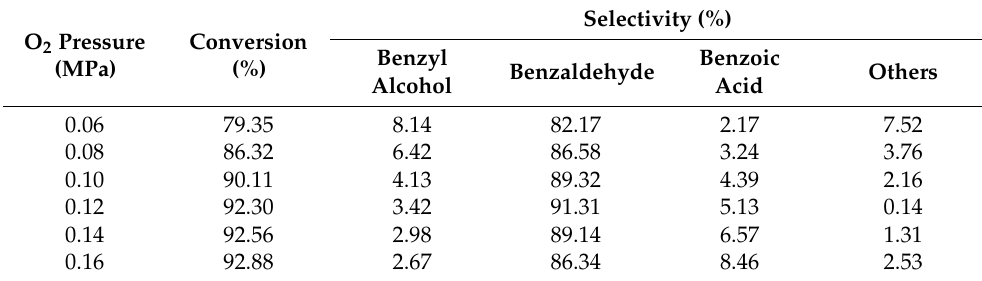
Table 1. Effects of the O 2